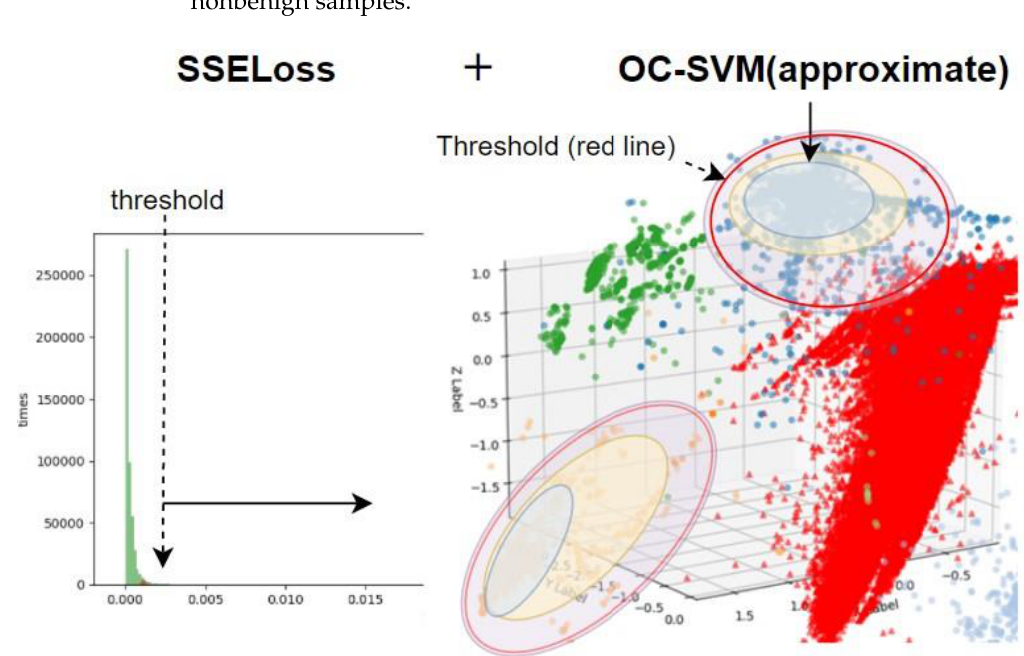
Figure 8. Unknown classification evaluation index.